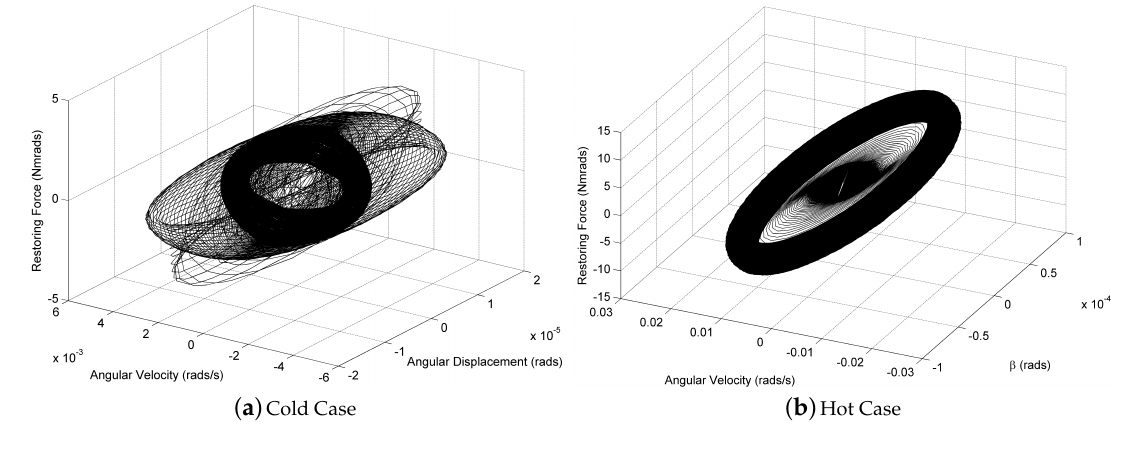
Figure 13. Restoring force